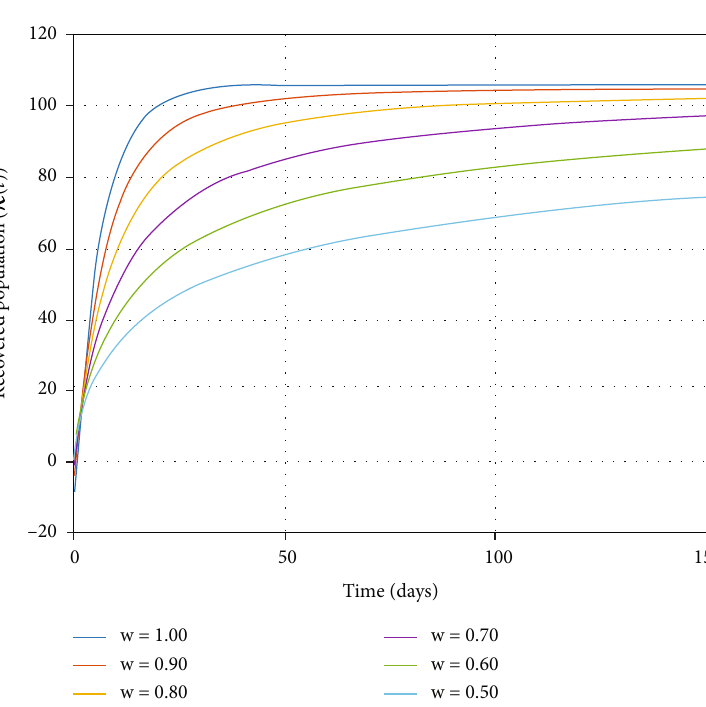
Figure 13: R ð t Þ by changing ω where m = 7